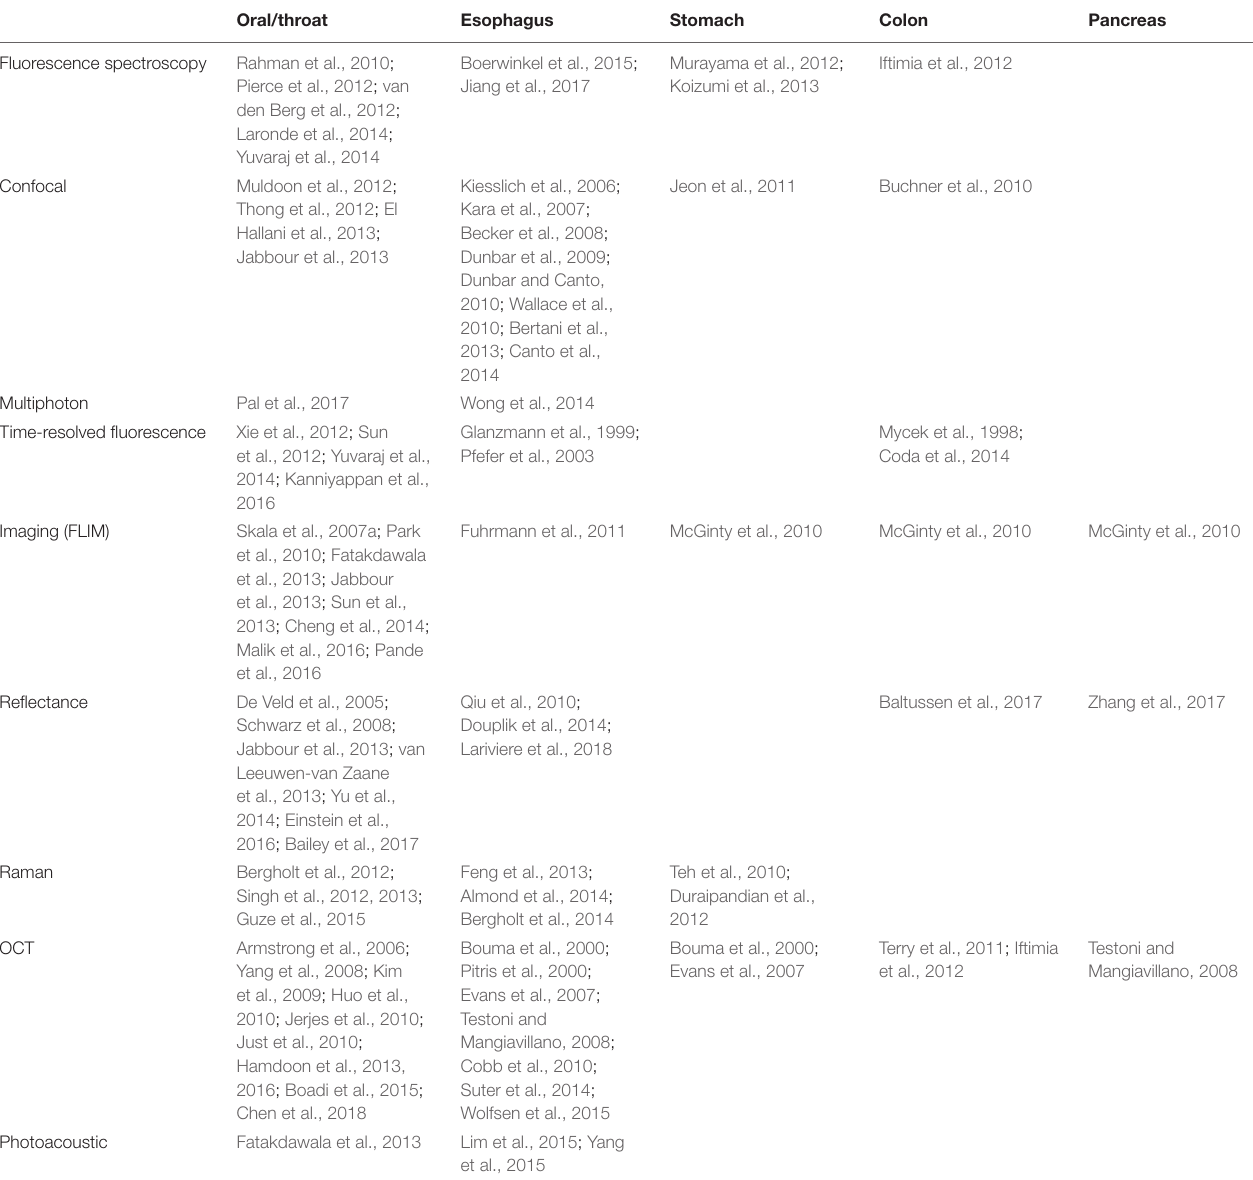
TABLE 1 | Optical biopsy modalities for gi cancer diagnosis: listed by organ. Oral/throat Esophagus Stomach Colon